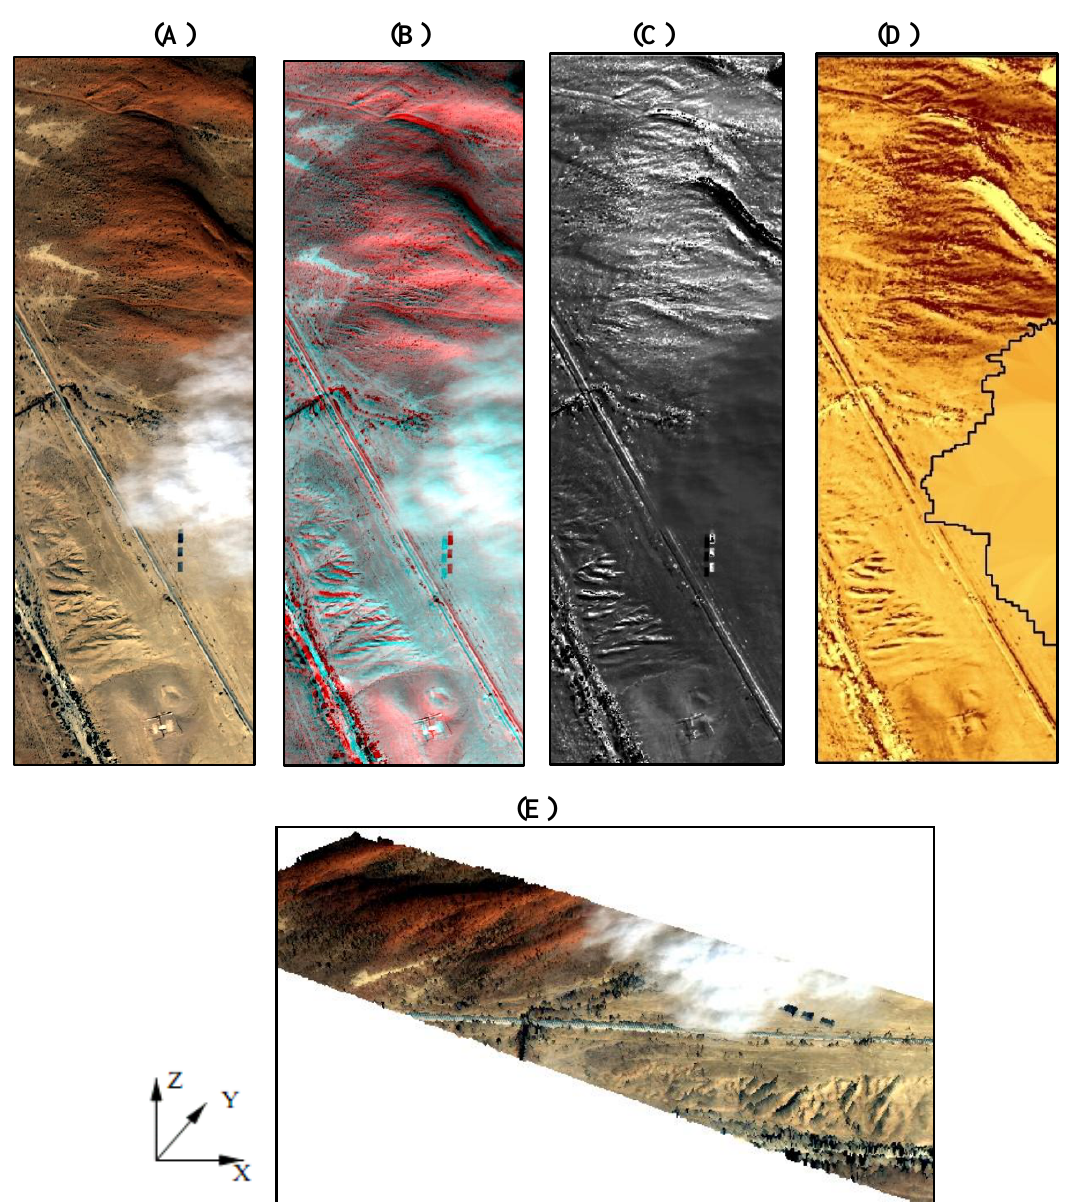
Figure 9. Digital Elevation Model (DEM). (A) AISA-Dual image (22 October 2006; 08:55 GMT; midlatitude summer model; 46.4° solar zenith; 164.6° azimuth angle), (B) 3-D stereo model, (C) boresight-calculated band, ( D ) relative DEM (black border = cloud-masked) modeled with the Kriging algorithm (0 m 30 m), (E) AISA-Dual image in 3-D view (x axis 1,500 m, y axis 500 m, z axis (relative to the scene elevation) 30